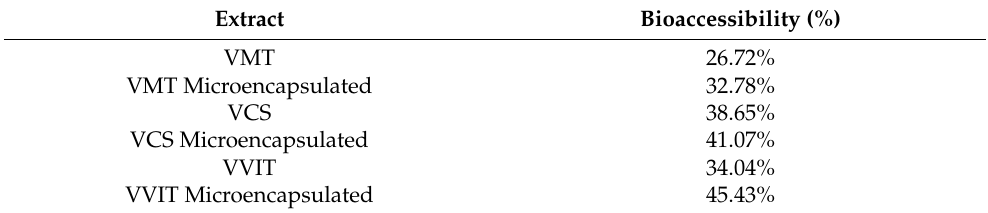
Table 6. Bioaccessibility of VMT, VCS and VVIT aqueous and microencapsulated extracts.